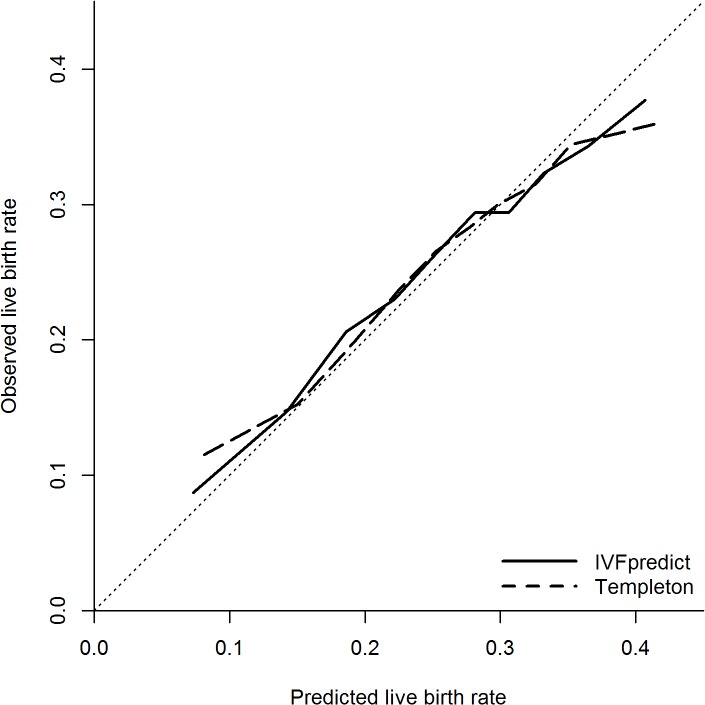
Calibration plot for updated IVFpredict and Templeton models.Based on 130,960 IVF cycles. Hosmer-Lemeshow test statistics: p<0.001. Solid line, updated IVFpredict model; dashed line, updated Templeton model; dotted, diagonal line, perfect prediction (reference).